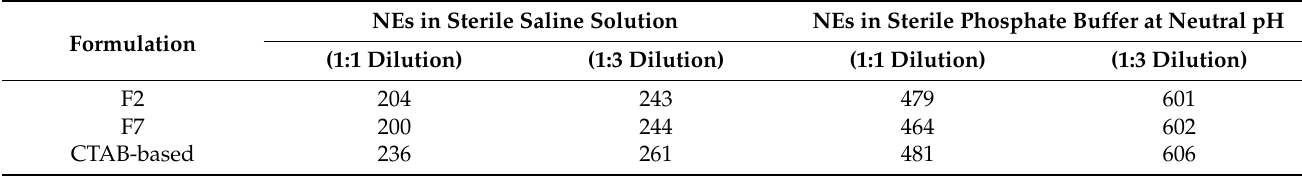
Table 8. Osmolality of the diluted formulation in different solution at different ratios.